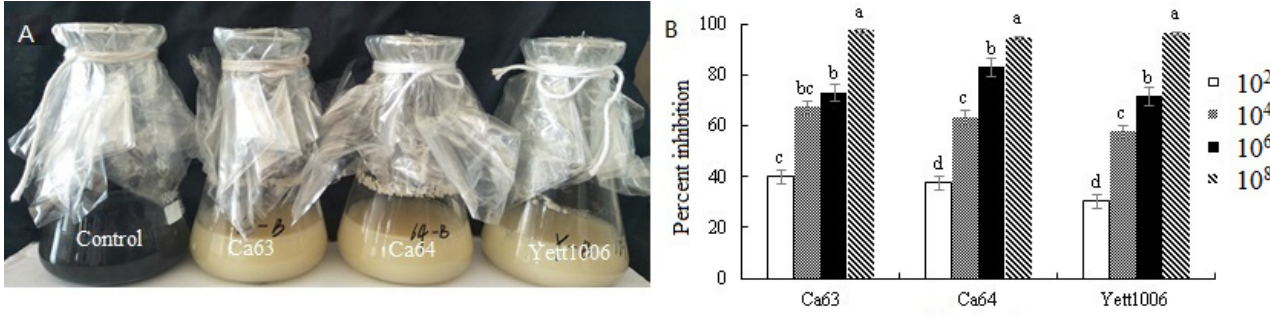
Figure 2. Evaluation of biocontrol abilities of three yeast strains against Botrytis cinerea . ( A ) Inhibition effect of three biocontrol yeast strains (10 8 CFU mL − 1 ) on mycelia growth of Botrytis cinerea after 7 days of incubation. ( B ) Inhibition rate of three biocontrol yeast strains against Botrytis cinerea . Error bars represent the standard deviations of means ( n = 3), and different letters within the same figure stand for significant differences among four concentration levels at p < 0.05.